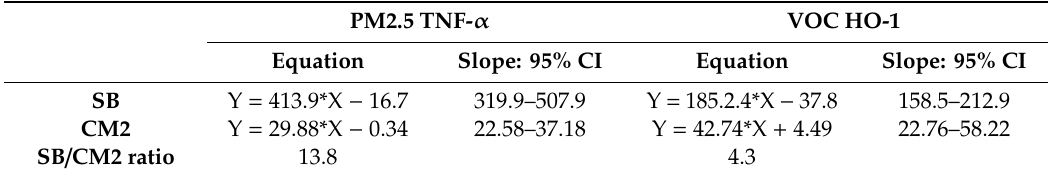
Table 3. Biological properties of SB and CM2